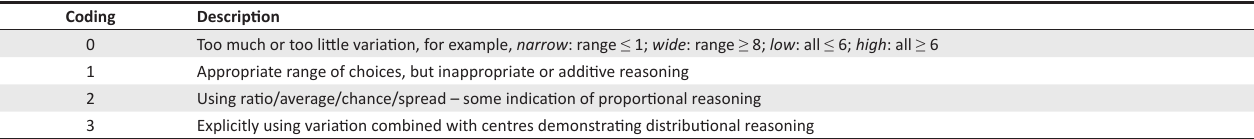
TABLE 4: Codes for Question 3: Reasons for expectations.